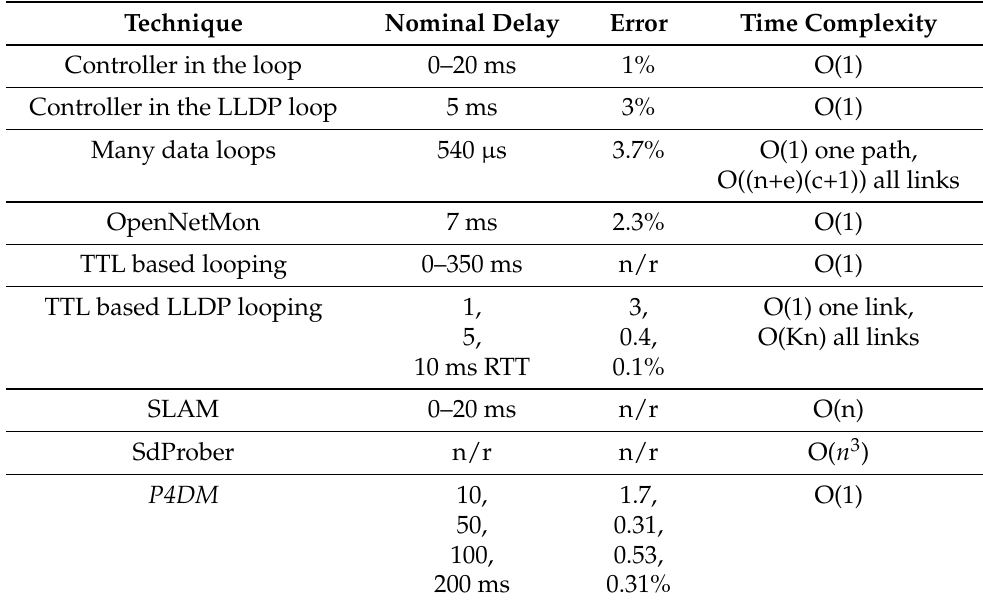
Table 2. Algorithm